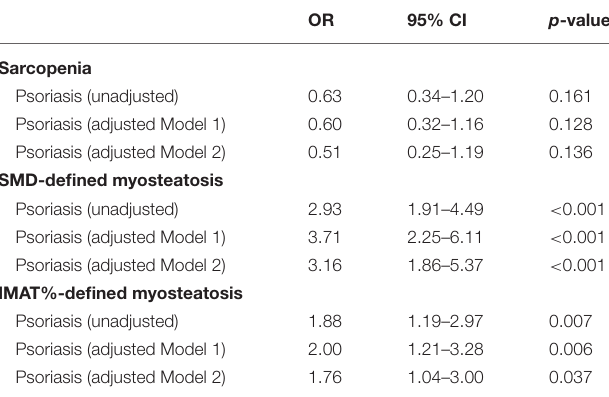
TABLE 3 | Association of psoriasis with sarcopenia or myosteatosis by logistic regression analysis in the study population after propensity score matching. OR 95% CI p -value